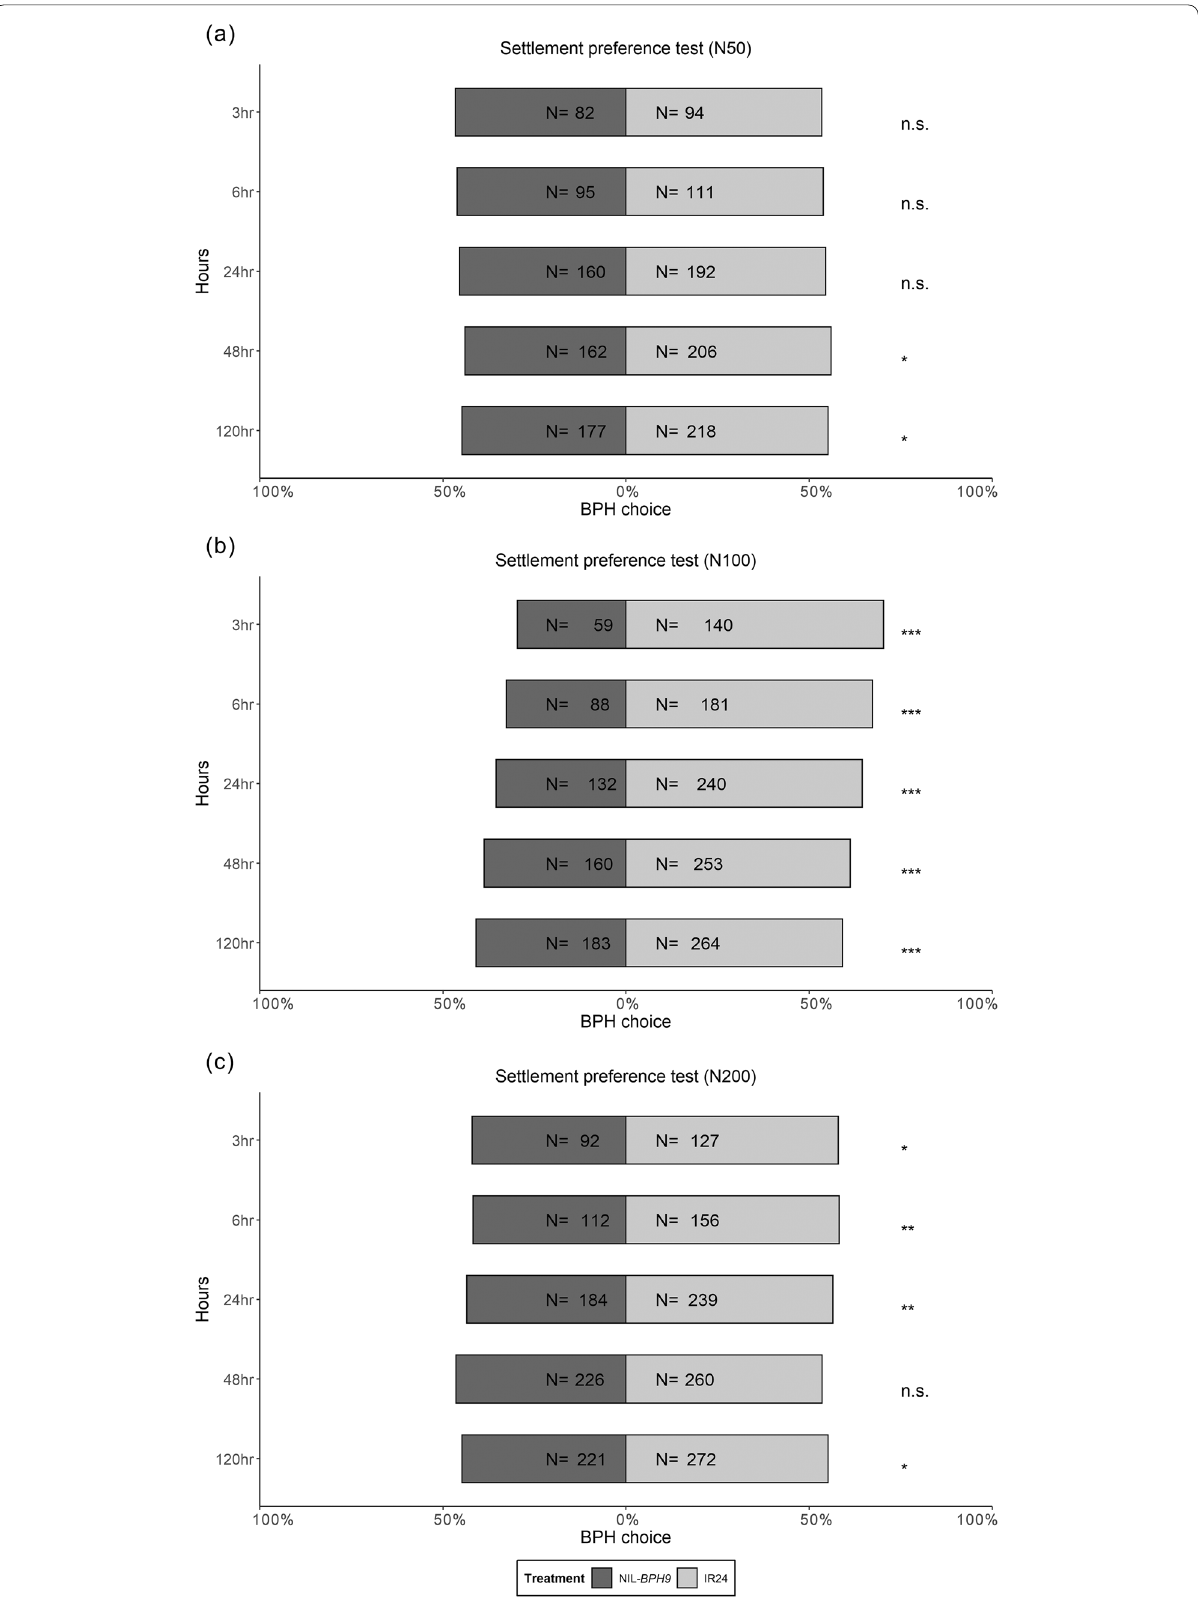
Fig. 6 (See legend on previous